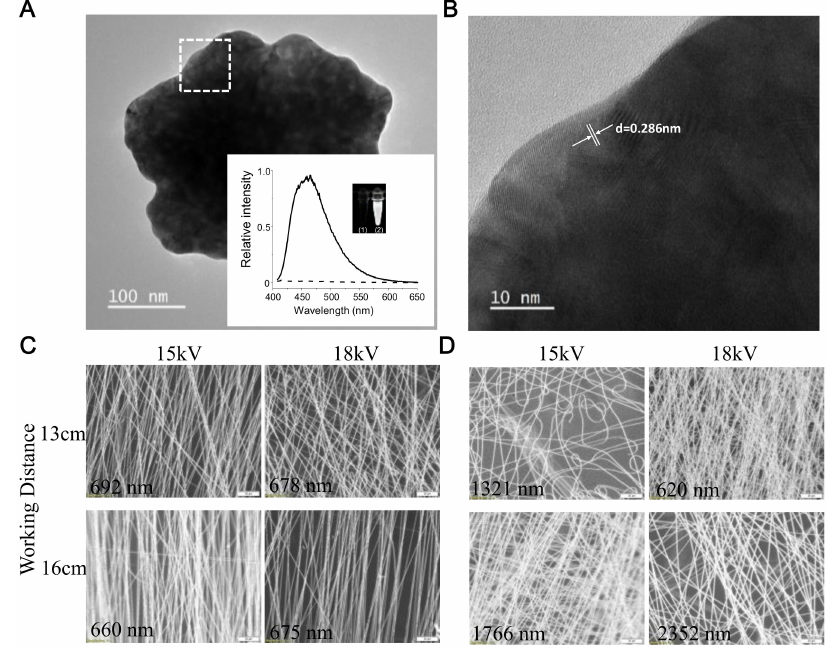
Figure 2. TEM and optical images of QG particles and nanofibers. ( A ) Low-magnification and ( B ) high-resolution TEM images (square region) showing a QG particle. The inset in ( A ) shows the fluorescence characterization of the QG particle. ( C ) 10 wt% and ( D ) 13 wt%